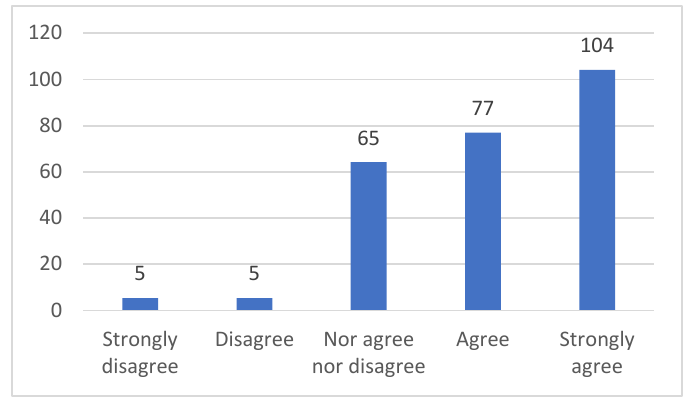
Figure 14. Answers to question 5: The execution of practical exercises with technological applications improve the learning of mathematical concepts.